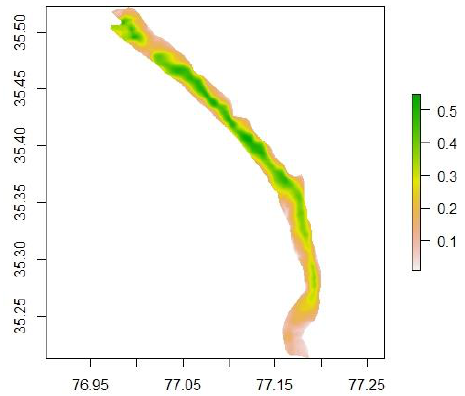
Figure 6: Siachen glacier velocity map using descending pass Sentinel-1A images (26 May 2018 and 7 June 2018) (Figure scale in m day -1